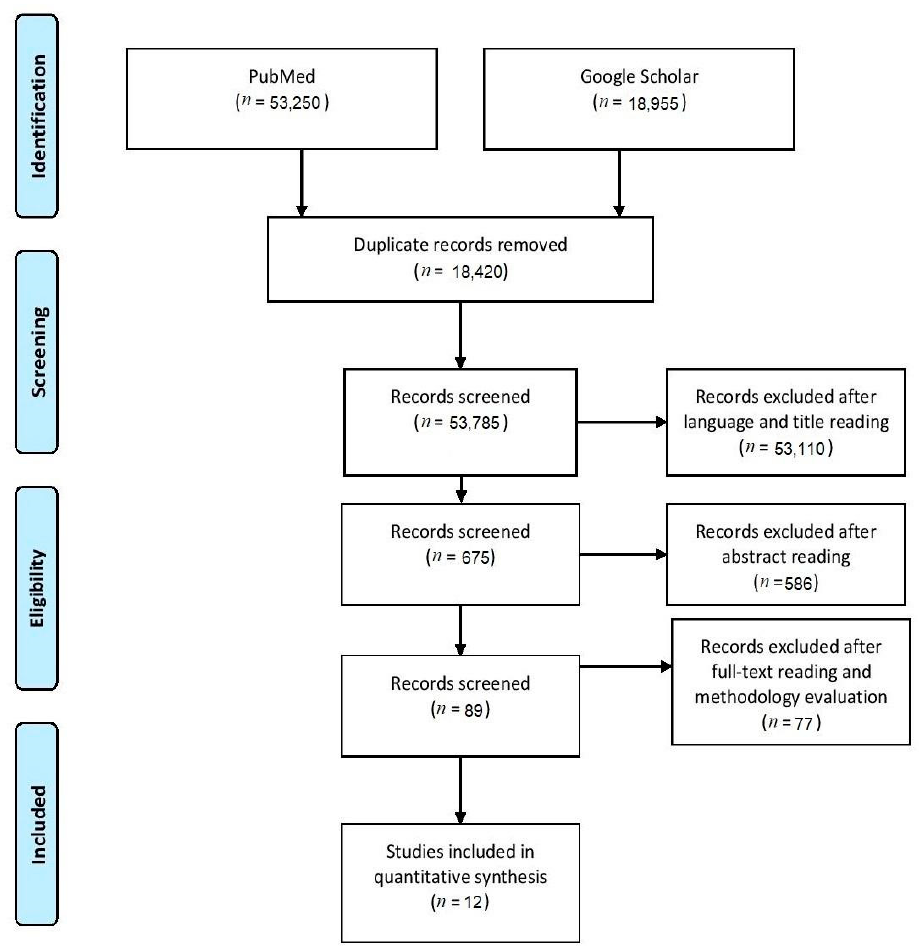
Figure 1. PRISMA flow diagram of the literature search and the studies selection process. Table 1. Descriptive statistics of all included studies after the systematic review with identified categorical moderator variables, categorized by differences in study populations (clinical diversity) and characteristics of the studies (methodological